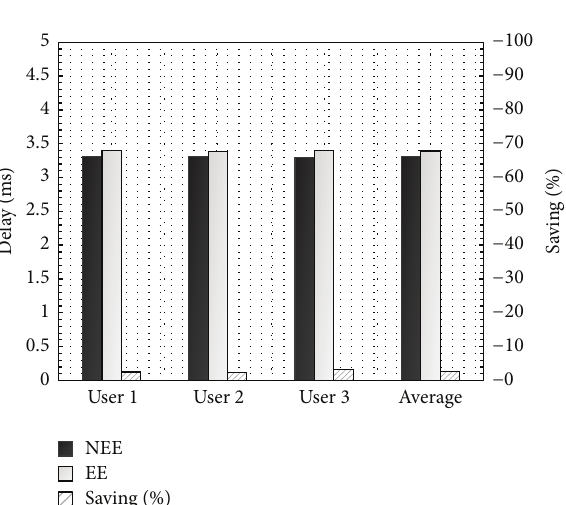
Figure 2: Power consumption with 𝑆 = 𝑁 = 3.